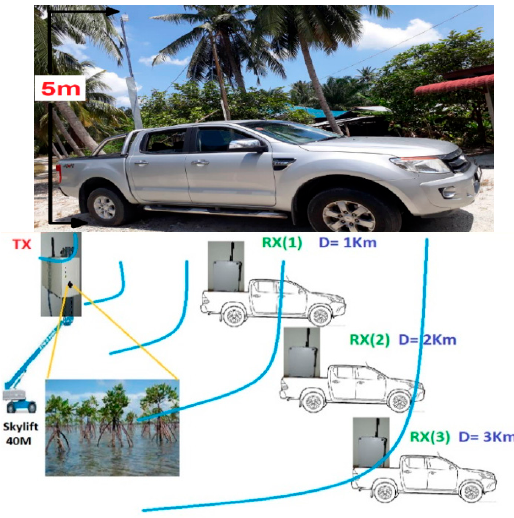
Figure 8. Completed receiver node fixed to the back of a four-wheel drive vehicle to enable testing at different distances.